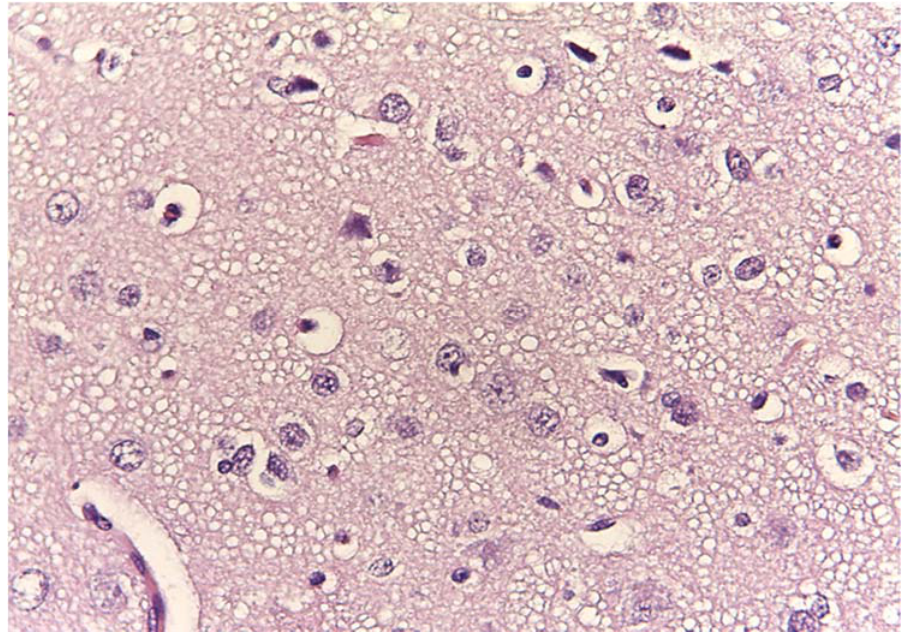
Figure 9. Spongy degeneration. Magnification: 40